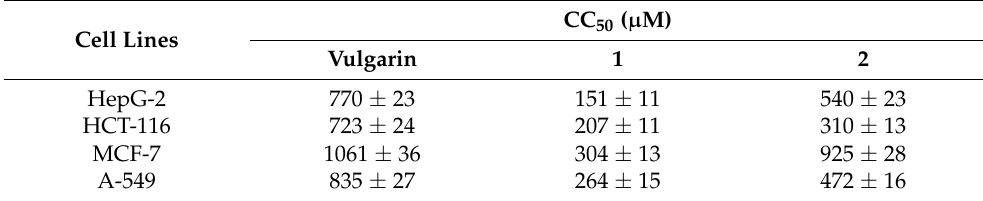
Table 3. CC 50 values (mean ± SD) of vulgarin and derivatives 1 and 2.